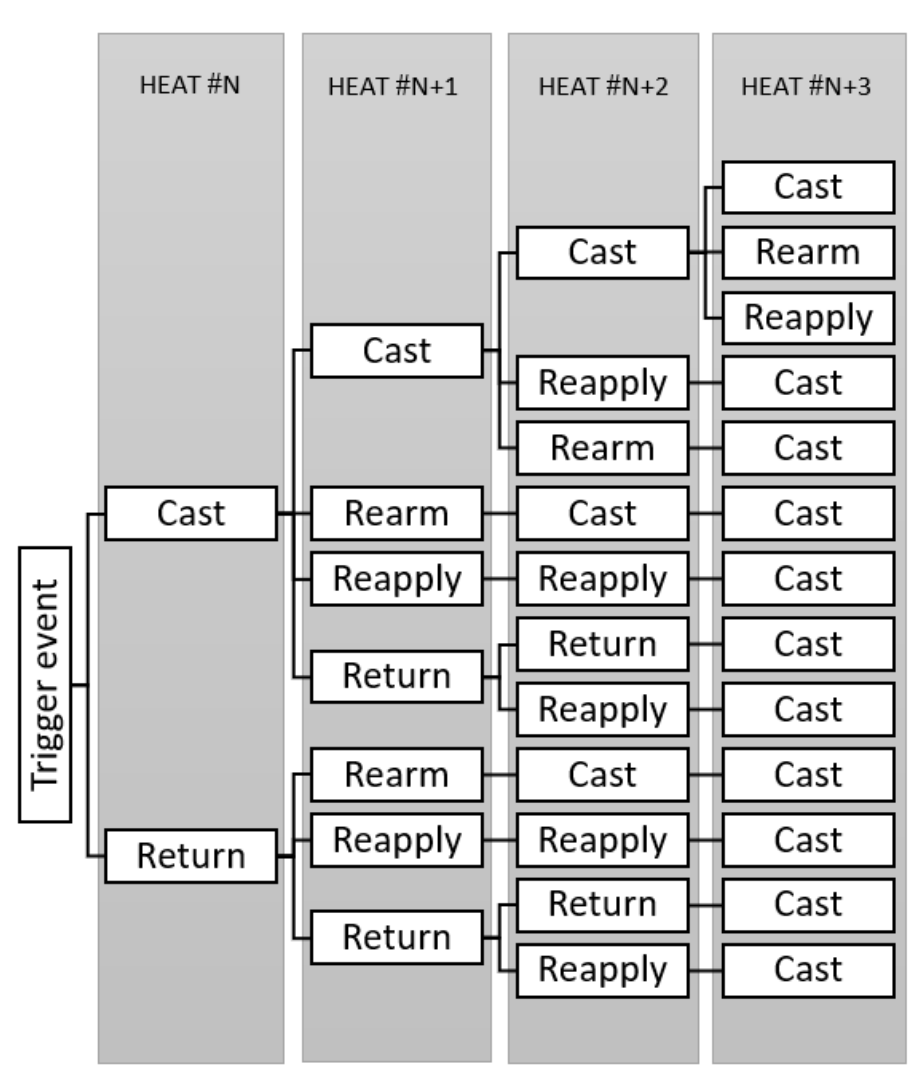
Figure 2. Decision Tree.